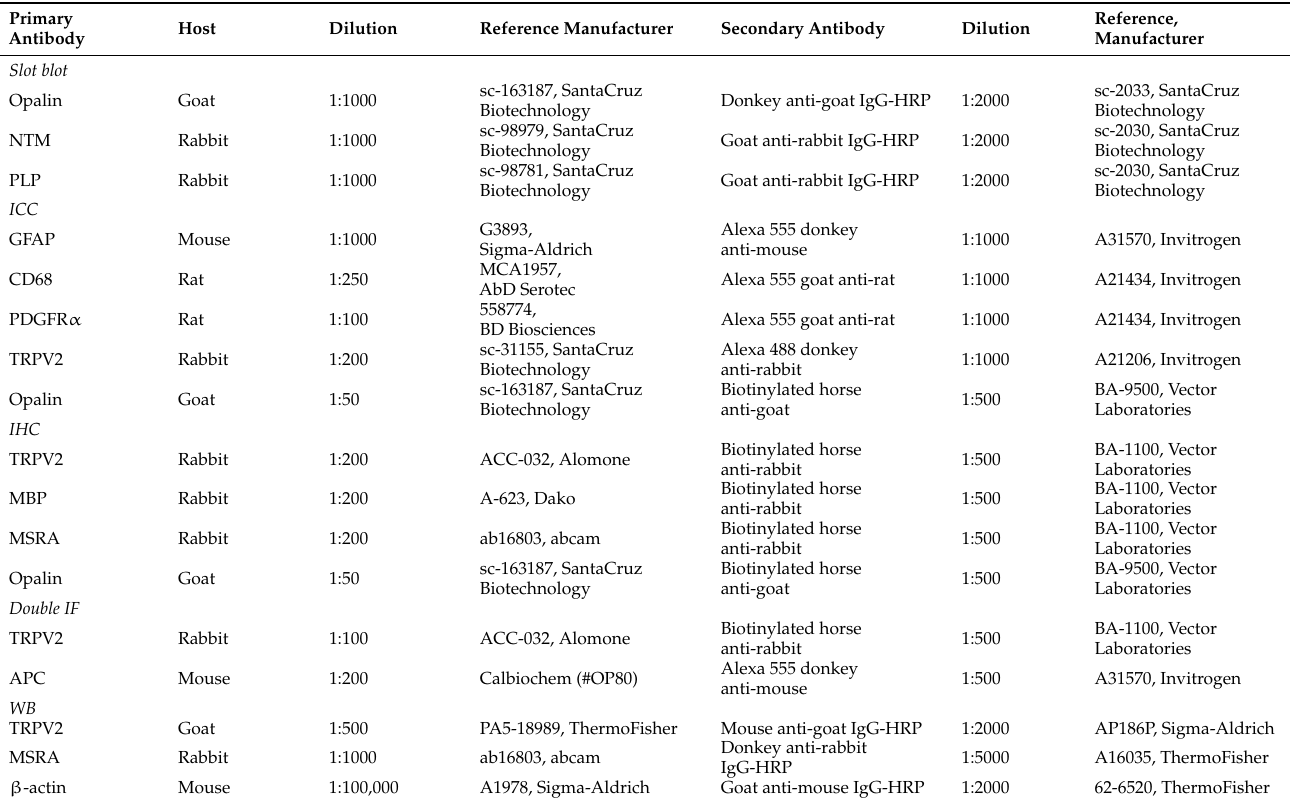
Table 2. List of antibodies and reagents used in the slot blot, immunocytochemistry (ICC), immuno- histochemistry (IHC), double immunofluorescence (IF) and western blot